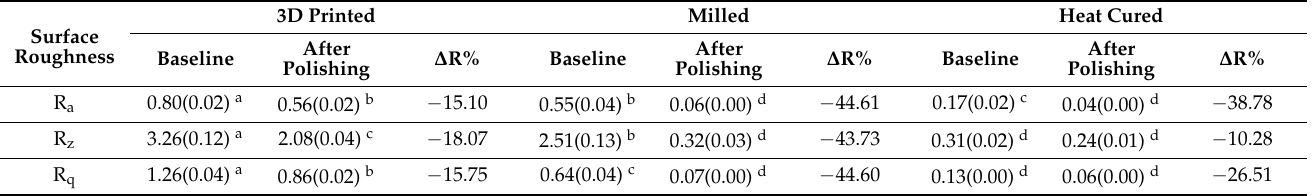
Table 1. Means ( ± SEM) of surface roughness parameters by resin that was used before and after polishing. 3D Printed Milled Heat Cured Surface Roughness